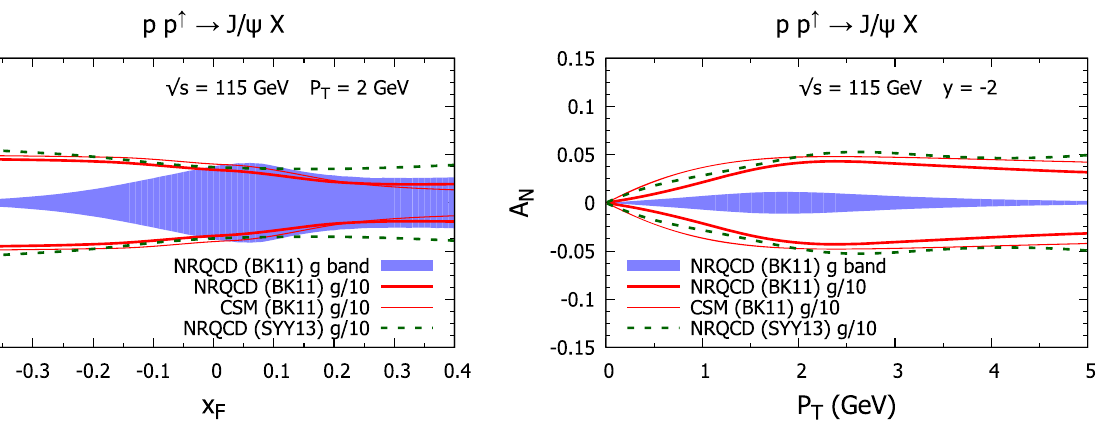
Fig. 5 Estimates of A N for the process p ↑ p → J /ψ X as a function √ s = 200 GeV and x F = 0 . 1 (left panel) and x F = − 0 . 1 of P T at (right panel), both in the CSM (green dashed line) and the NRQCD